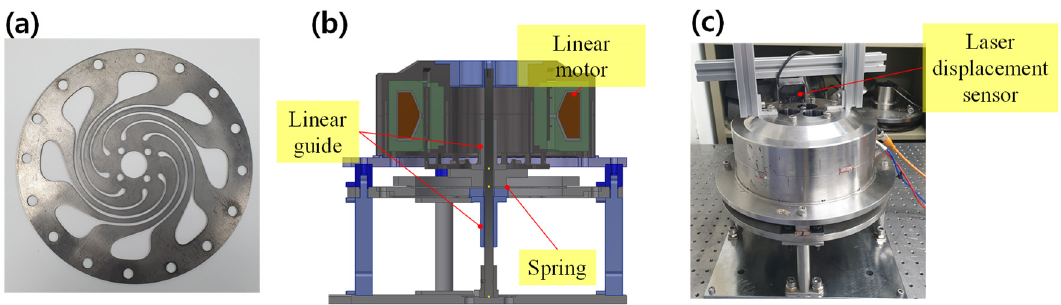
Figure 18. ( a ) Manufactured spring with the optimized design variables, ( b ) design cross-sectional view of the spring fatigue test rig, and ( c ) its photo.